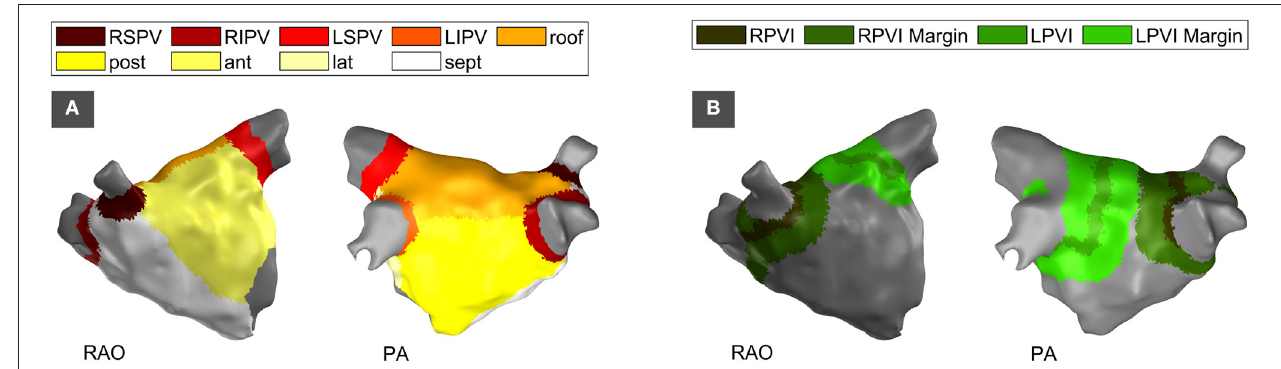
FIGURE 1 | Partitioning of the left atrium by anatomical region (A) and by structural region based on the location of PVI lesions (B) . Right-anterior-oblique (RAO) and posterior-anterior (PA) perspective. RSPV, right superior pulmonary vein; RIPV, right inferior pulmonary vein; LSPV, left superior pulmonary vein; LIPV, left inferior pulmonary vein; post, posterior; ant, anterior; lat, lateral; sept, septal; RPVI, right pulmonary vein isolation; LPVI, left pulmonary vein isolation; RAO, right-anterior-oblique view; PA, posterior-anterior